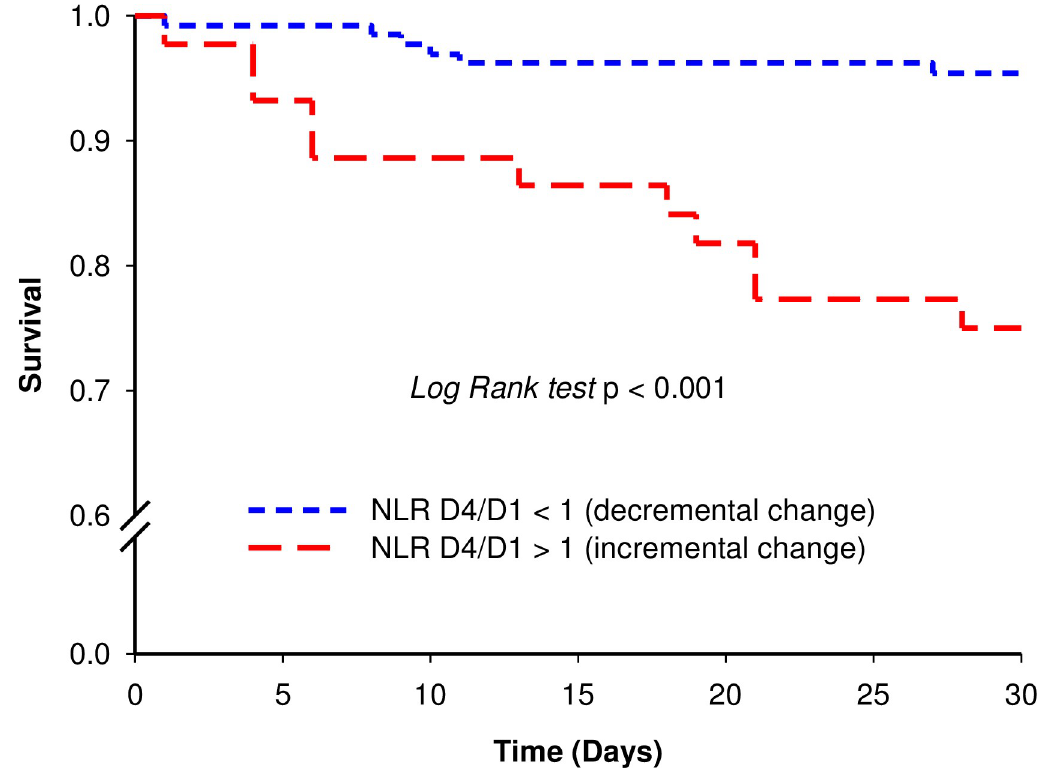
Fig 3. 30-day survival curves according to incremental or decremental NLR